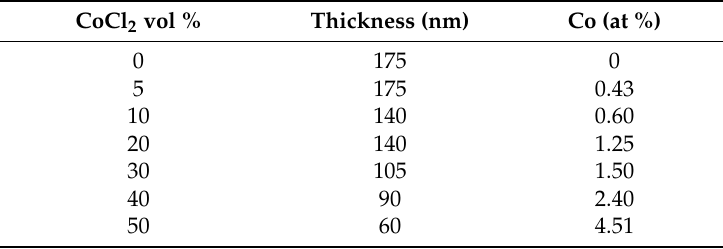
Table 1. Thin film thickness and Co dopant concentrations as a function of the CoCl 2 vol % in the precursor solution.